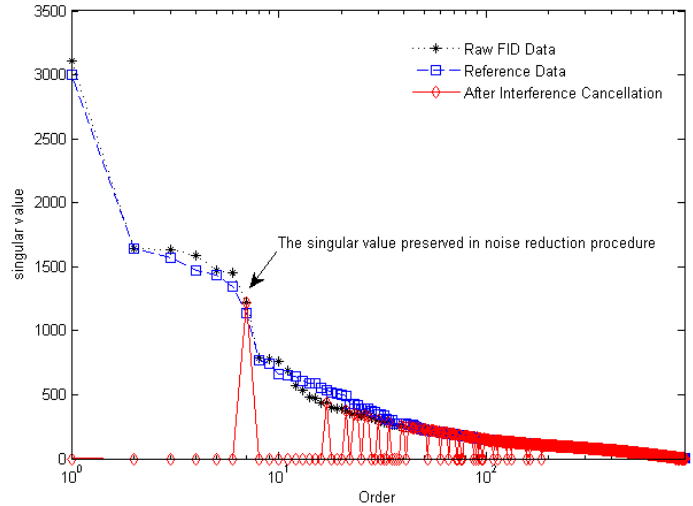
Figure 8. Singular value plots of Figure 7A–C. The marked singular value corresponds to Figure 7D.